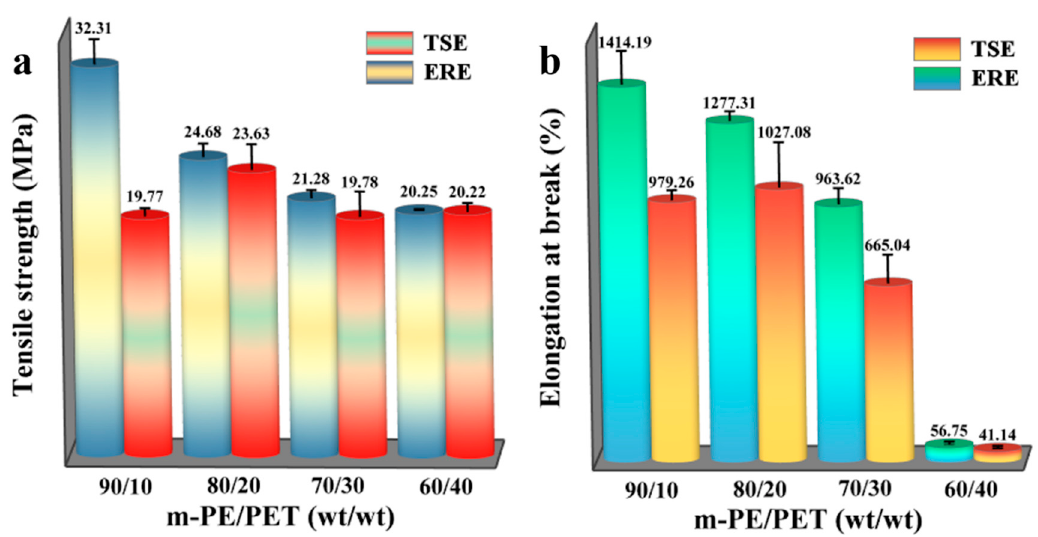
Figure 9. Tensile strength and elongation at break of m-PE / PET blends processed using ERE and TSE, respectively. ( a ) the tensile strength of the blends processed using ERE and TSE; ( b ) the elongation at break of the blends processed using ERE and TSE.